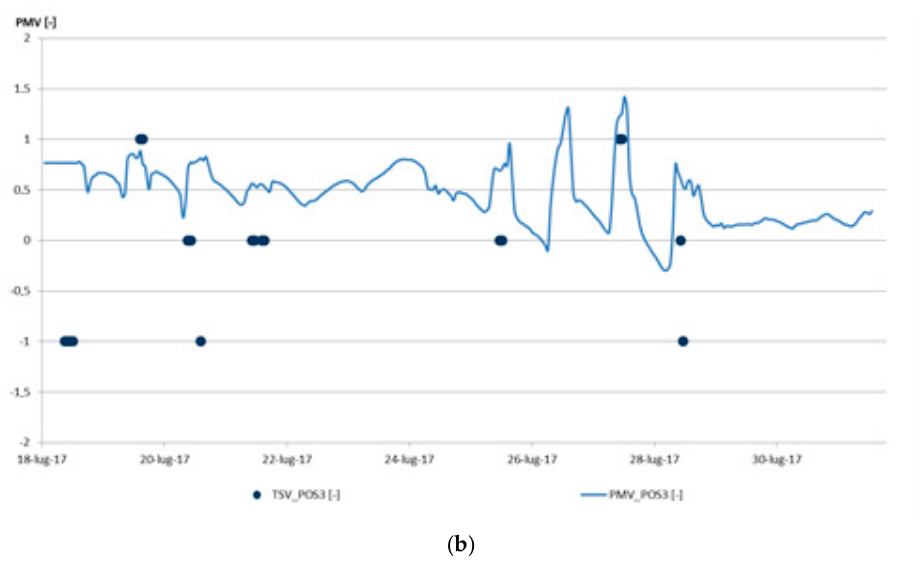
Figure 3. PMV and TSV: ( a ) Pos.1; ( b ) Pos.